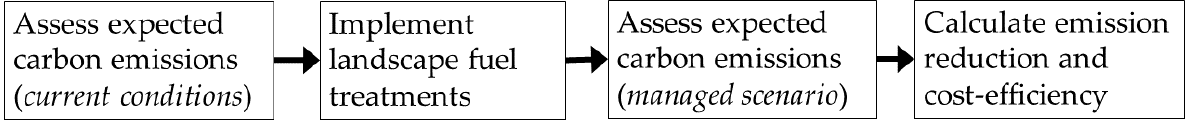
Figure A4. Methodological flowchart of the process conducted to estimate landscape fuel treatment cost-efficiency.